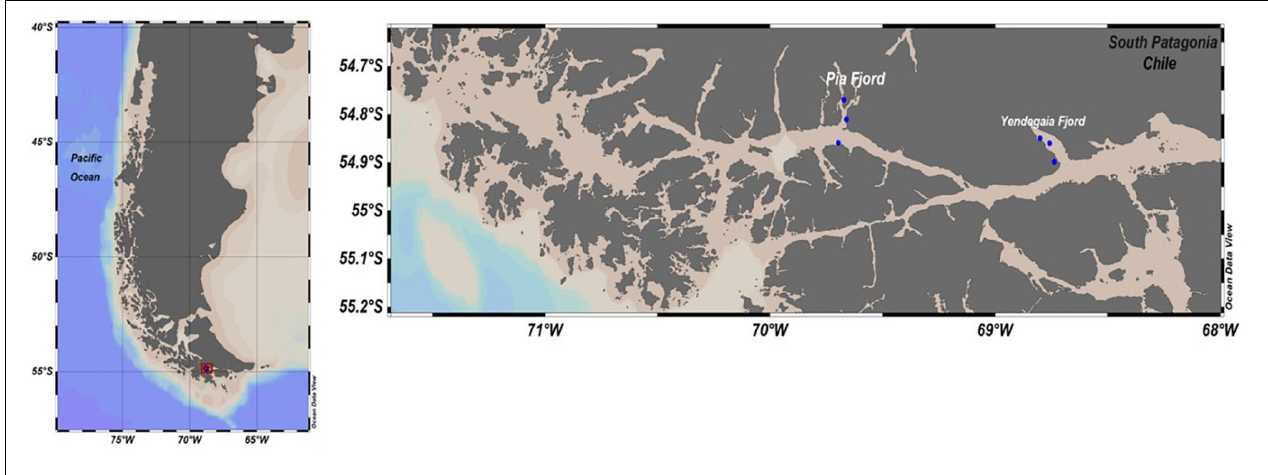
FIGURE 1 | Study area and sampling sites in the Pia and Yendegaia fjords in the southern Chilean Patagonia.